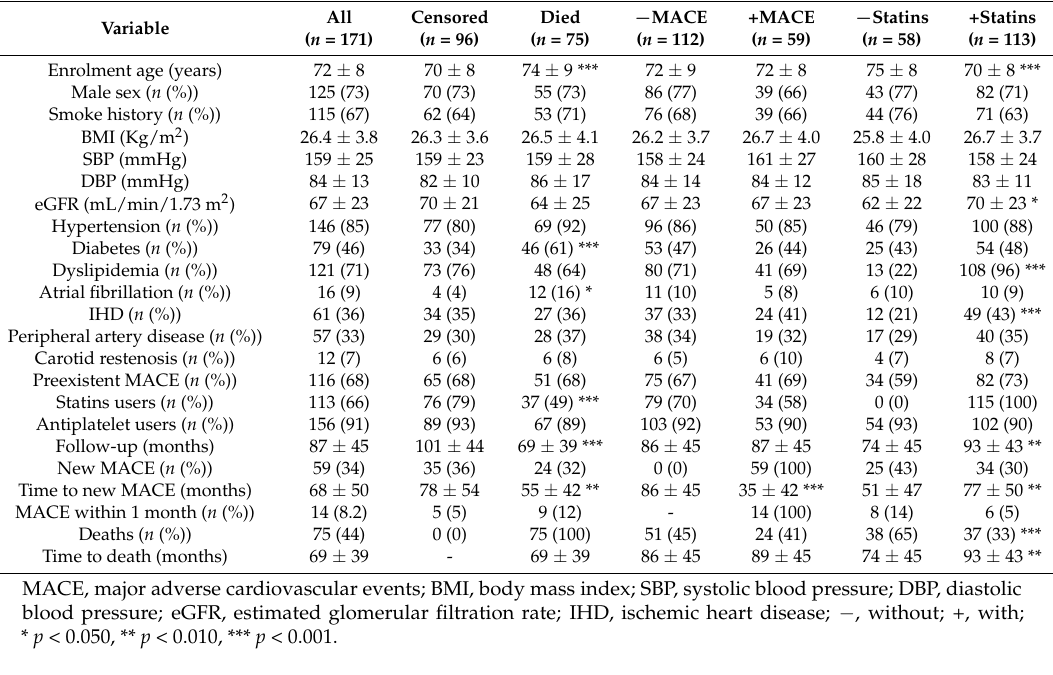
Table 1. General characteristic of all studied patients and of patients divided by groups: censored or death, with or without new MACE occurrence, and using or not using statins at baseline.